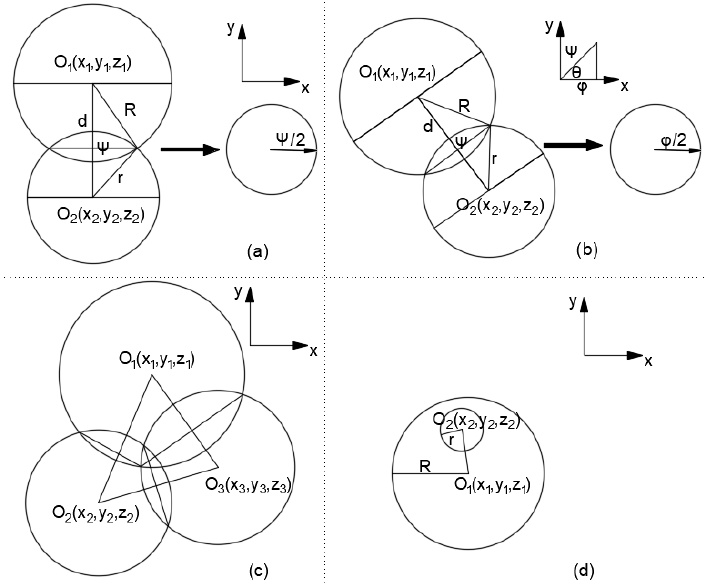
Figure 3. Effective contact area between different cement particles, modified from references [47,48]: ( a ) two particles interconnected in a plane perpendicular to the y-axis; ( b ) two particles not interconnected in a plane perpendicular to the y-axis; ( c ) three or more particles interconnected; ( d ) the larger particle O 1 contained the smaller particle O 2 completely